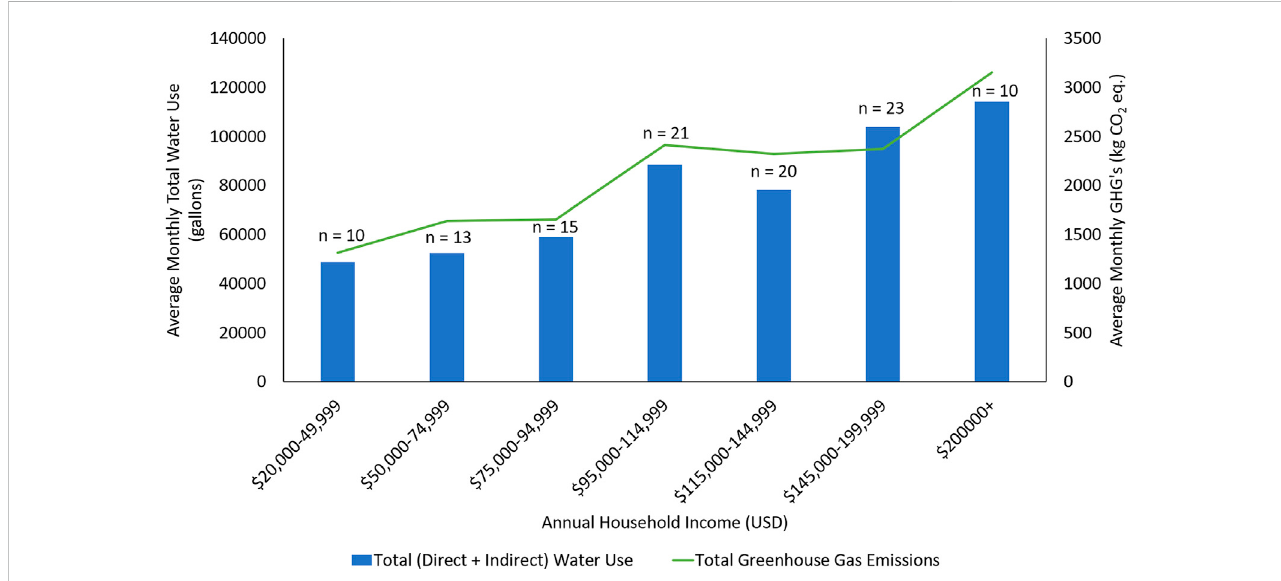
FIGURE 10 Total (direct and indirect) water use and total GHG emissions by household income range.